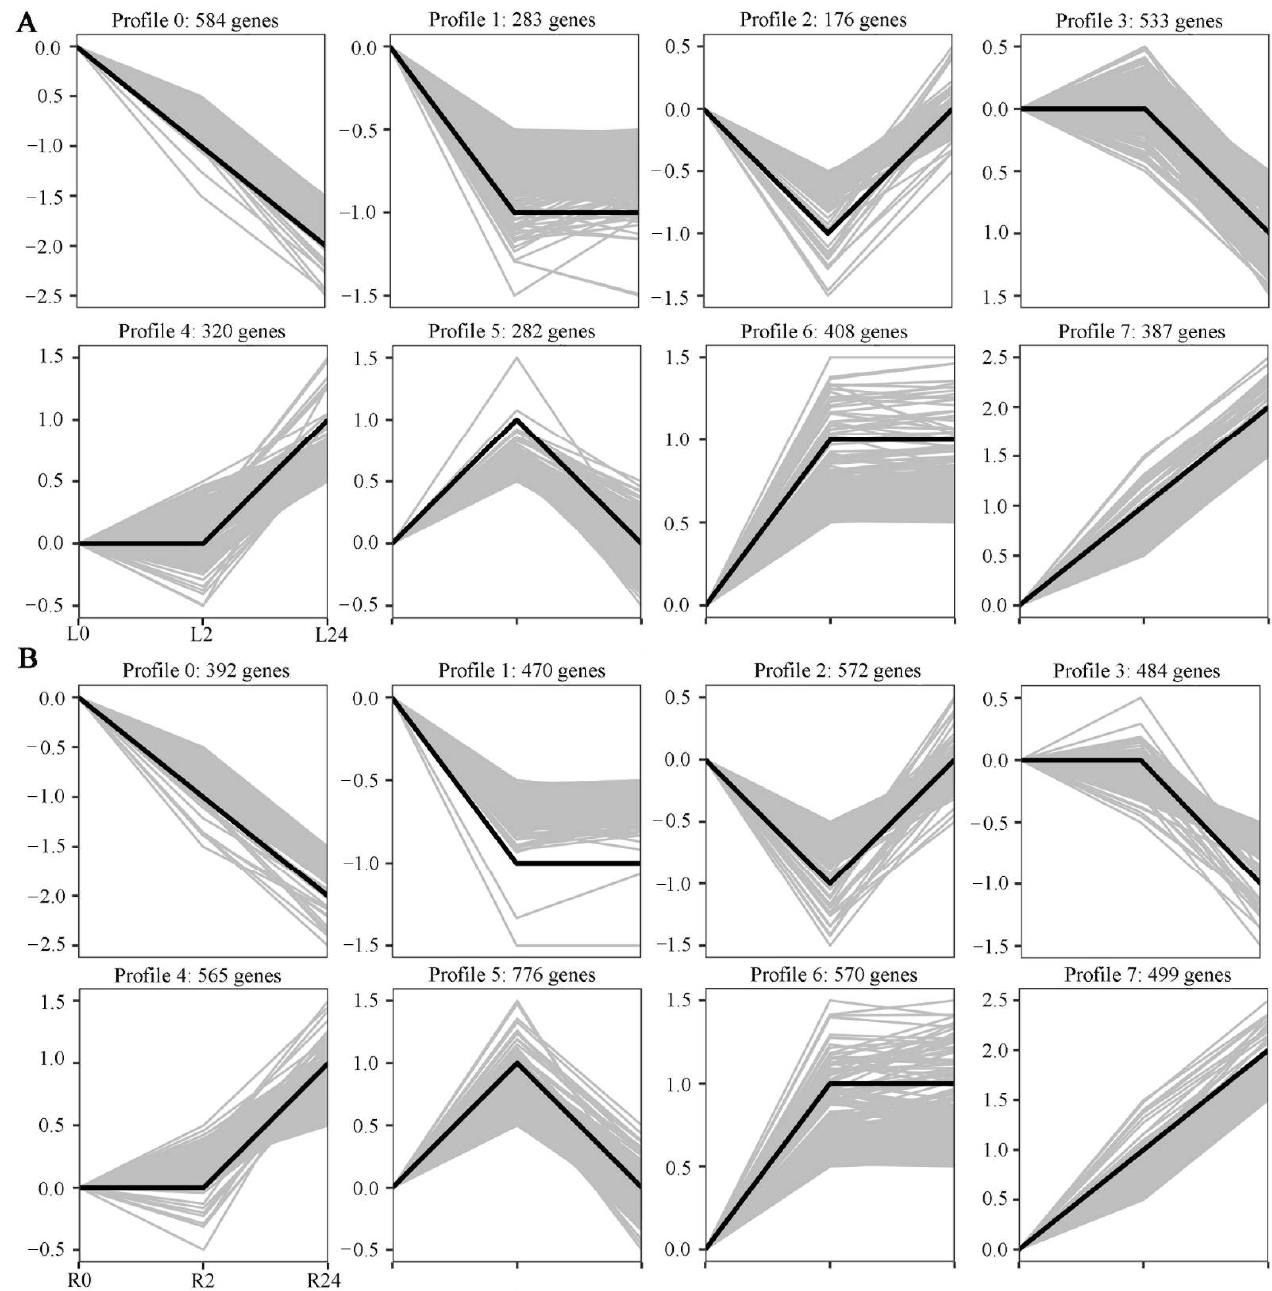
Figure 4. Differentially expressed gene expression patterns. The light grey lines represent the ex- pression pattern of each gene, while the thick, dark lines represent the expression tendency of all the genes. ( A ) Patterns of gene expression in the leaves across three time points. ( B ) Patterns of gene expression in the roots across three time points.